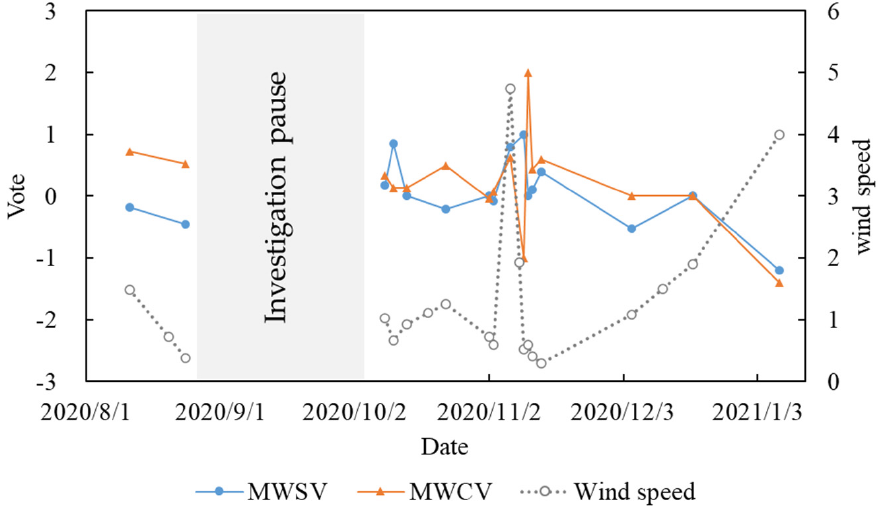
Figure 6. MWSV and MWCV values in the square.